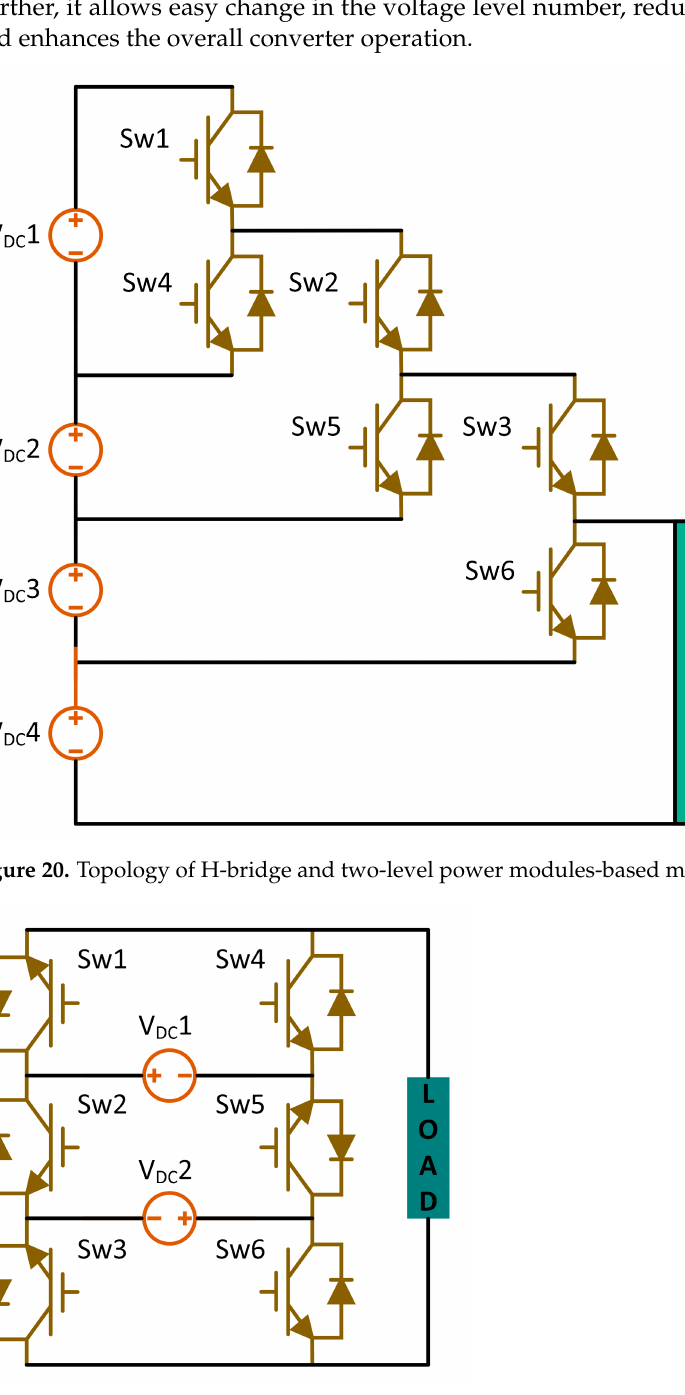
Figure 21. Topology of cross connected sources based multilevel